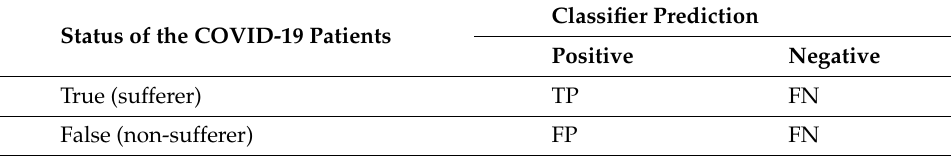
Table 1. Constructed confusion